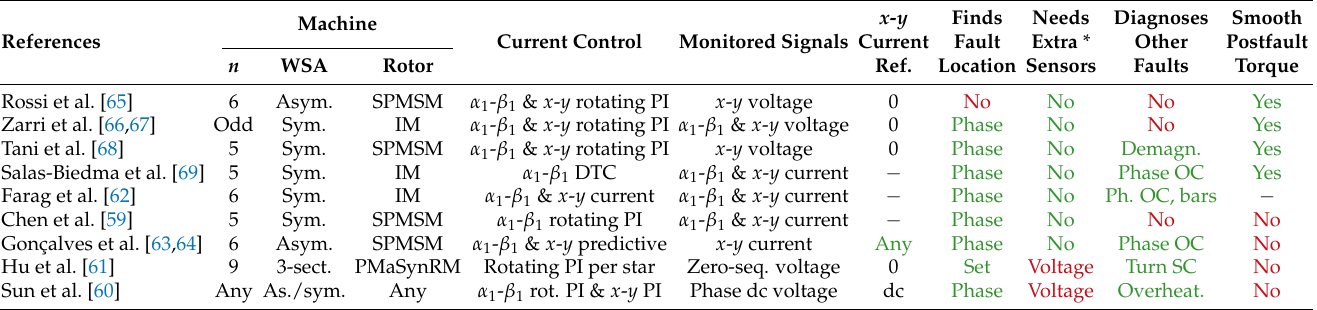
Table 7. Methods for detecting high-resistance connections (Section 4) in multiphase applications in the literature. x - y Finds Needs Diagnoses SmoothMachine Current